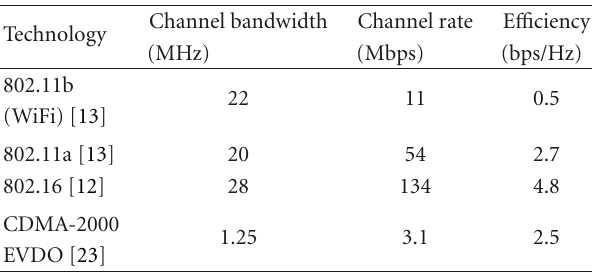
Table 3: Modulation e ffi ciency of several wireless technologies.